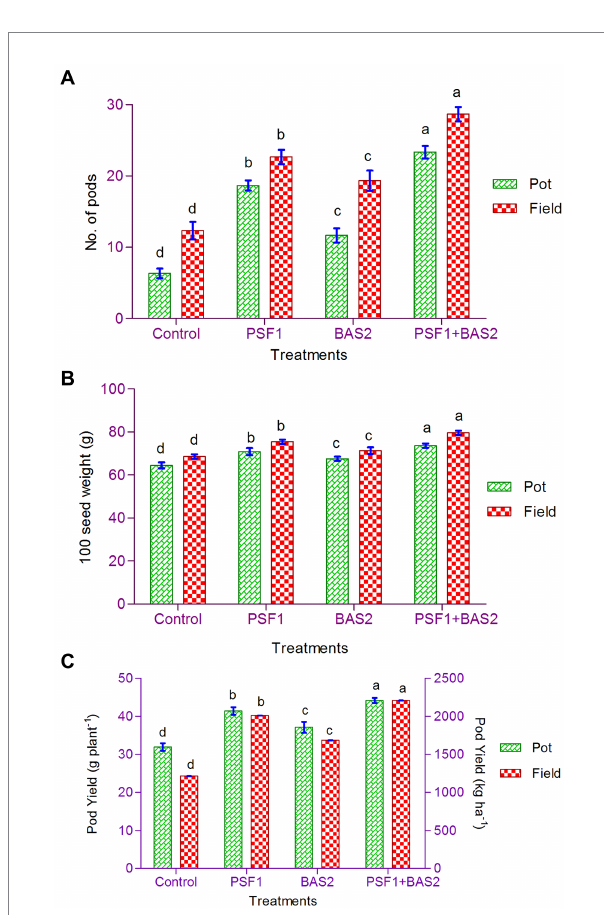
FIGURE 6 Effect of PGPR biostimulants Pseudomonas fluorescens (PSF1) and Bacillus subtilis (BAS2) on yield attributes (A) number of pods; (B) 100 seed weight; and (C) pod yield under pot and field conditions. Error bar represents standard deviation ( n = 3). Small alphabetical letters above the error bar indicate significant difference between treatments according to Tukey’s post-hoc test ( p ≤